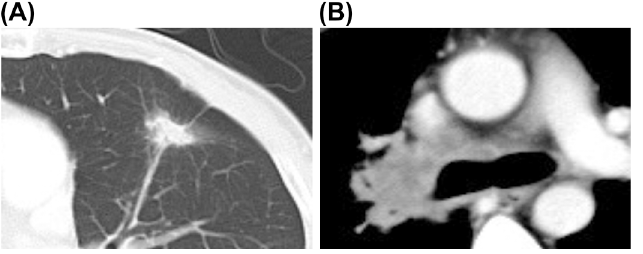
Fig 1. Computed tomography images of a lung adenocarcinoma showing ground-glass opacity with solid components. (A) Thoracic computed tomography reveals ground-glass opacity with solid components. (B) Thoracic computed tomography reveals extranodal invasion of the lymph